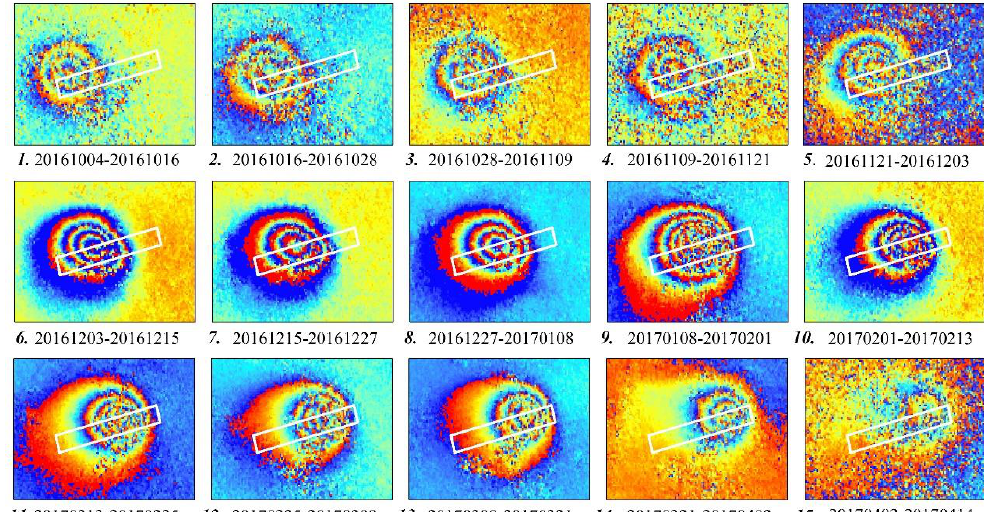
Figure 9. Fifteen consecutive 12-day interferograms over the ground above WP 92,606.